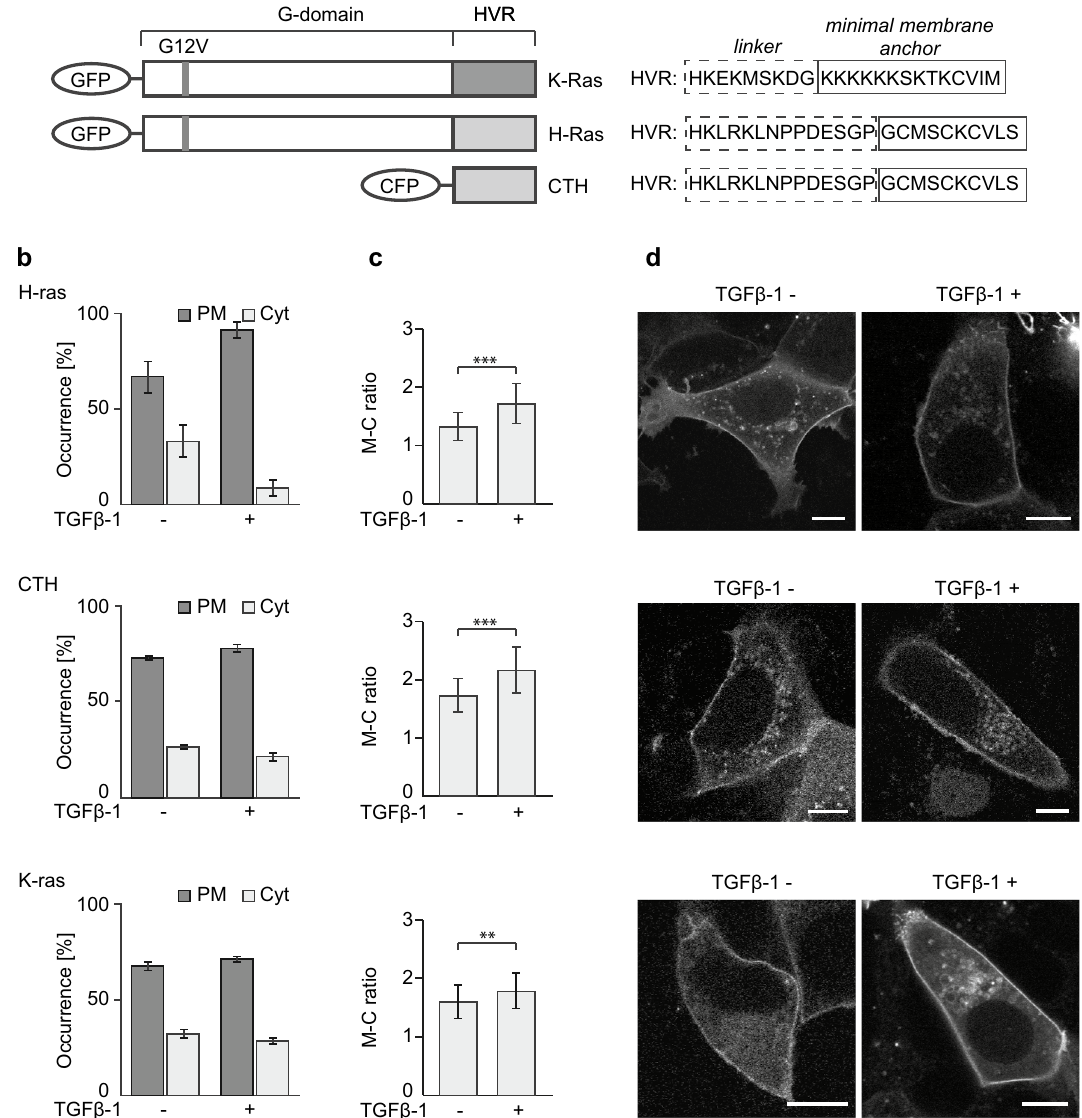
Figure 1. H-ras, CTH, and K-ras redistribute from the cytoplasm to the plasma membrane after TGFβ-1 treatment. Comparison of MCF7 cells expressing GFP-H-ras G12V (H-ras), CFP-CTH (CTH), or GFP-K- ras G12V (K-ras) treated or not with TGFβ-1 for 2 days. Data shown come from merging three independent biological replicates of each protein (for separate analysis of all replicates see Fig. S2). ( a ) Schematic representation of all Ras constructs used. HVR, hypervariable region. ( b ) Comparison of ratios between cells with cytoplasmic (Cyt) and plasma membrane (PM) localization (H-ras n ≥ 63, CTH n ≥ 62, K-ras n ≥ 159), error bars represent ± 0.5 SD. ( c ) Comparison of membrane-to-cytoplasm ratios (M-C ratio) (H-ras n ≥ 94, CTH n ≥ 80, K-ras n ≥ 199), error bars represent ± 0.5 SD, stars indicate statistically significant differences (* p = 0.01– 0.05, ** p = 0.001–0.009, *** p < 0.001; for exact p -values see Table S1). ( d ) Representative images of all tested conditions. Scale bar 10